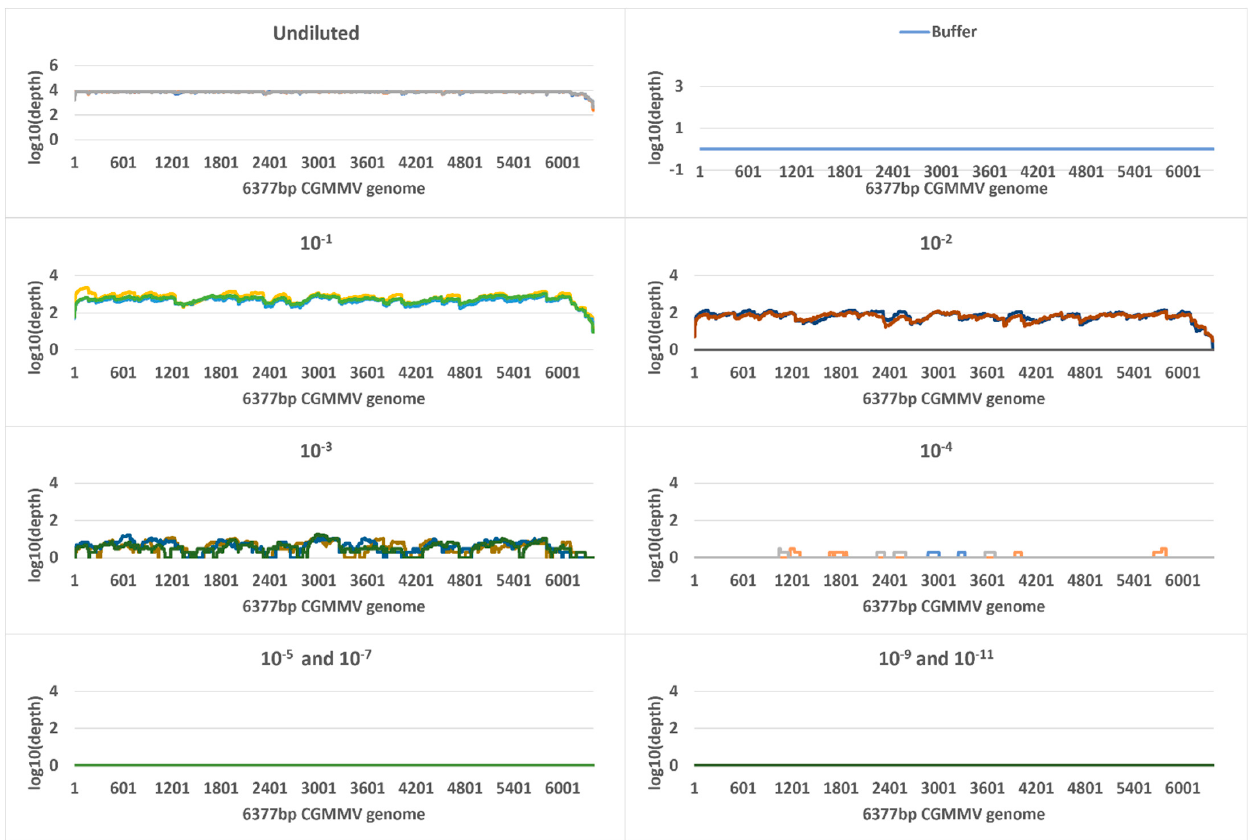
Figure 4. Genome coverage and read depth profiles of plant panel tenfold dilution series samples, from undiluted to 1 in 100,000,000,000 (10 − 11 ) across the 6377 nt cucumber green mottle mosaic virus (CGMMV) genome (VPRI43306) detected using Illumina metagenomic sequencing. Each plant panel dilution was tested in triplicate and the technical replicates are shown as different colours. Depth is in standard Logarithmic Scale.